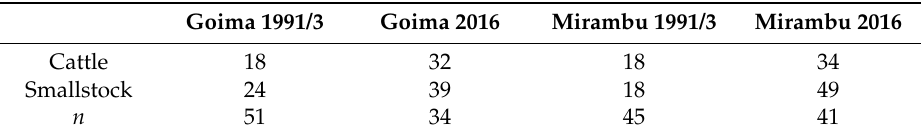
Table 6. Percentage of Families owning cattle and smallstock, Goima and